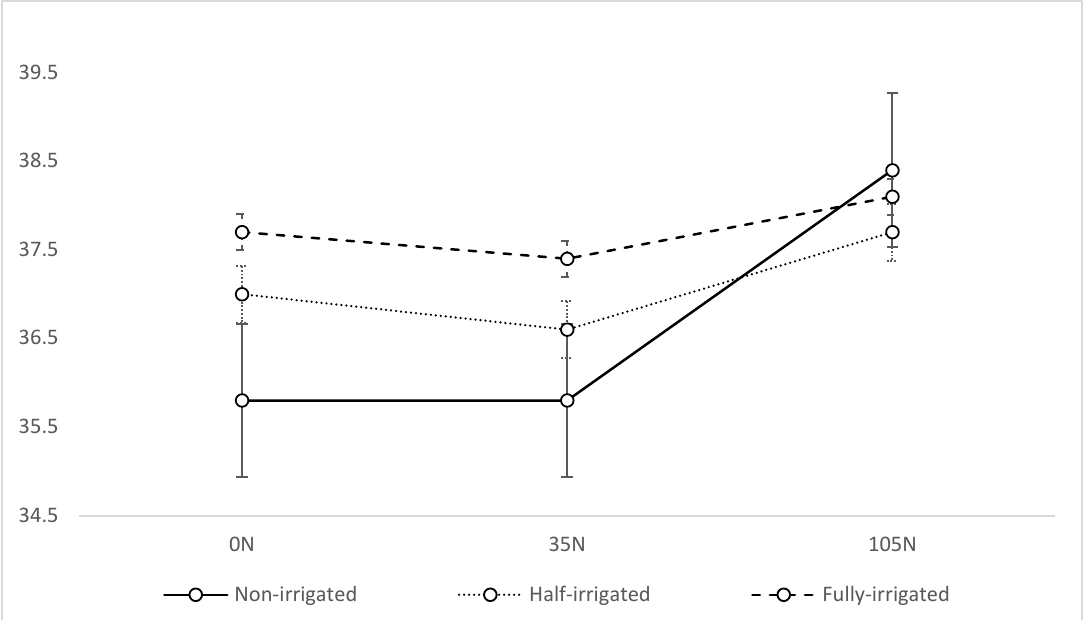
Table 18. The effect of different fertilization rates on the seed oil concentration (%) of soybean (cv. Pannonia Kincse) under different irrigation regimes, averaged among 2017, 2018, and 2019 in Debrecen, Hungary. Treatment